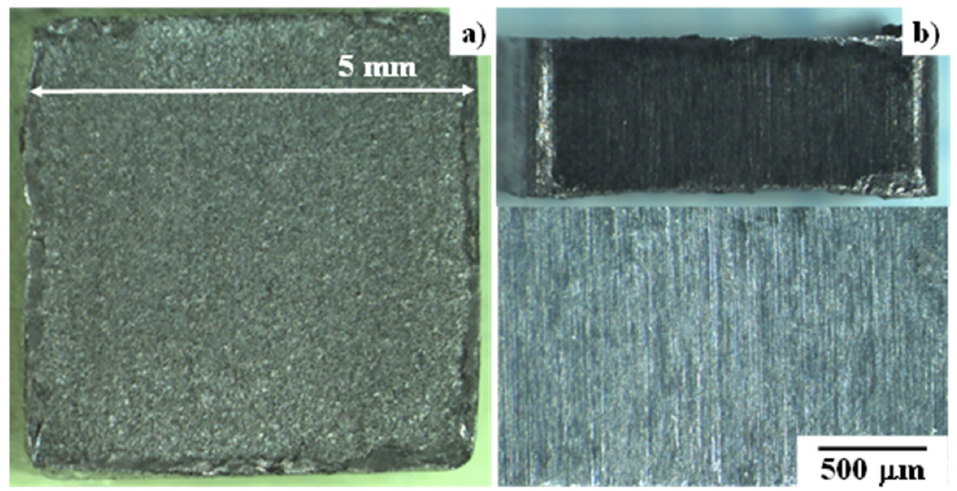
Figure 9. Observation of the sheared square blank using the CS-YXR7 punch: ( a ) top view of punched-out titanium blank and ( b ) side surface of punched-out titanium blank.